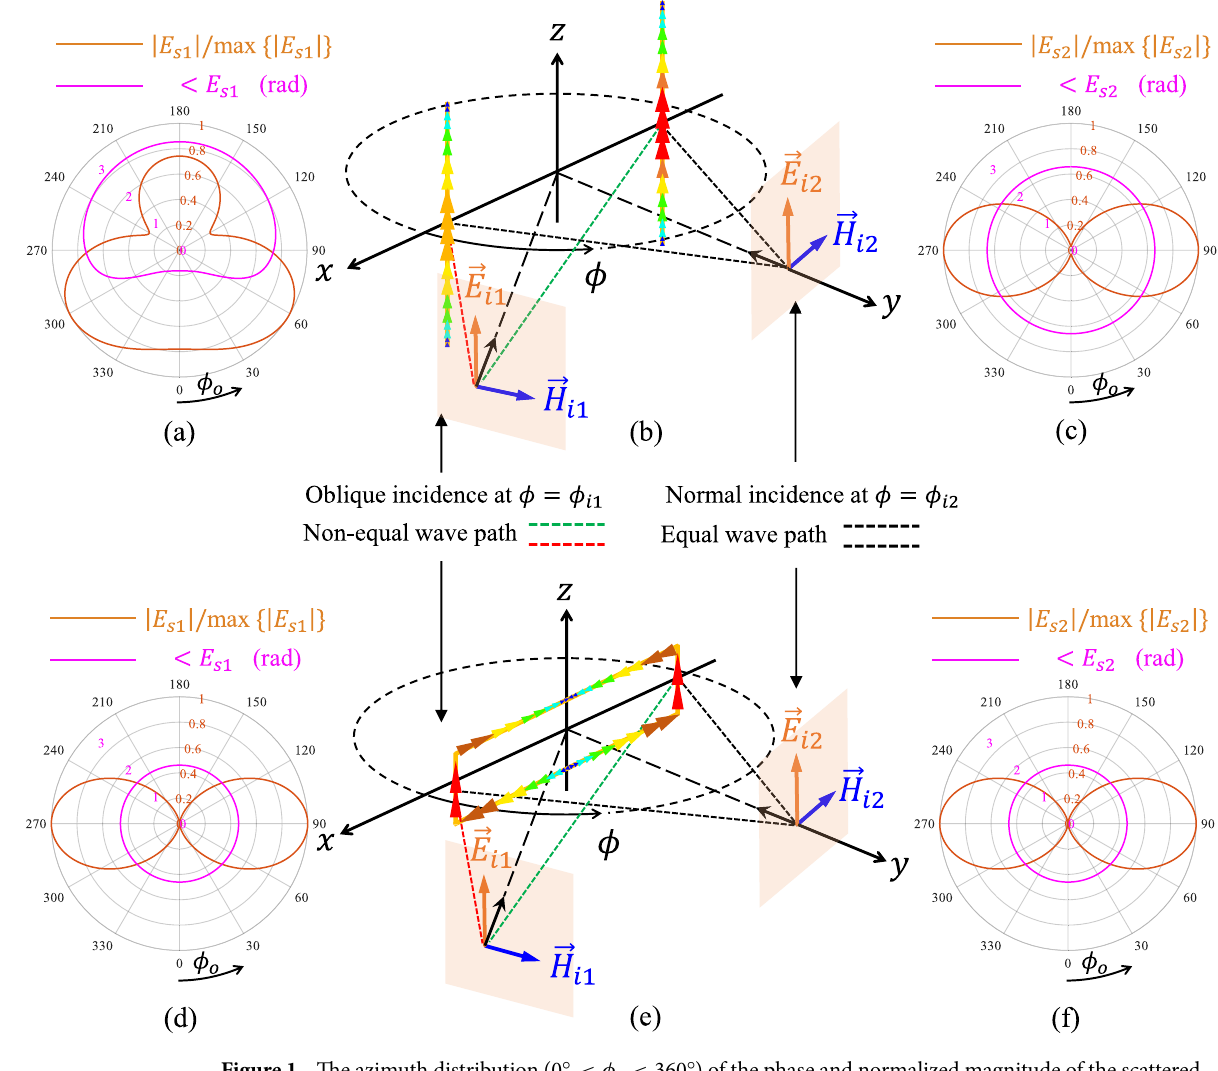
Figure 1. The azimuth distribution ( 0 ◦ < φ o < 360 ◦ ) of the phase and normalized magnitude of the scattered electric field from two dipoles for ( a ) oblique incidence ( c ) normal incidence. The azimuth distribution ( 0 ◦ < φ o < 360 ◦ ) of the phase and normalized magnitude of the scattered electric field from rectangular loop for ( d ) oblique incidence ( f ) normal incidence. Symmetrical and non-depolarizing scattering structure ( b ) without radial resonance [two equal-length coupled dipoles] ( e ) with radial resonance [rectangular loop]. All the data are obtained in